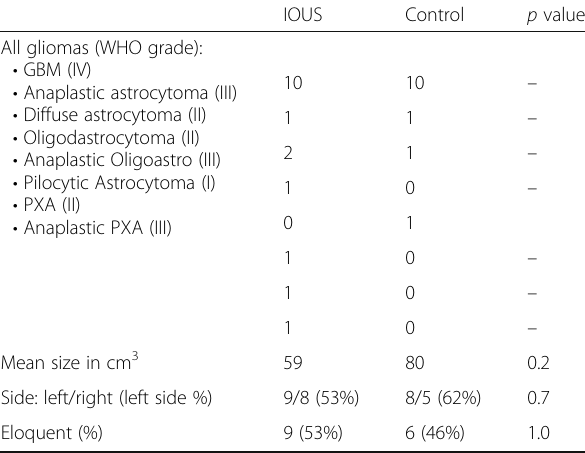
Table 2 Tumor characteristics